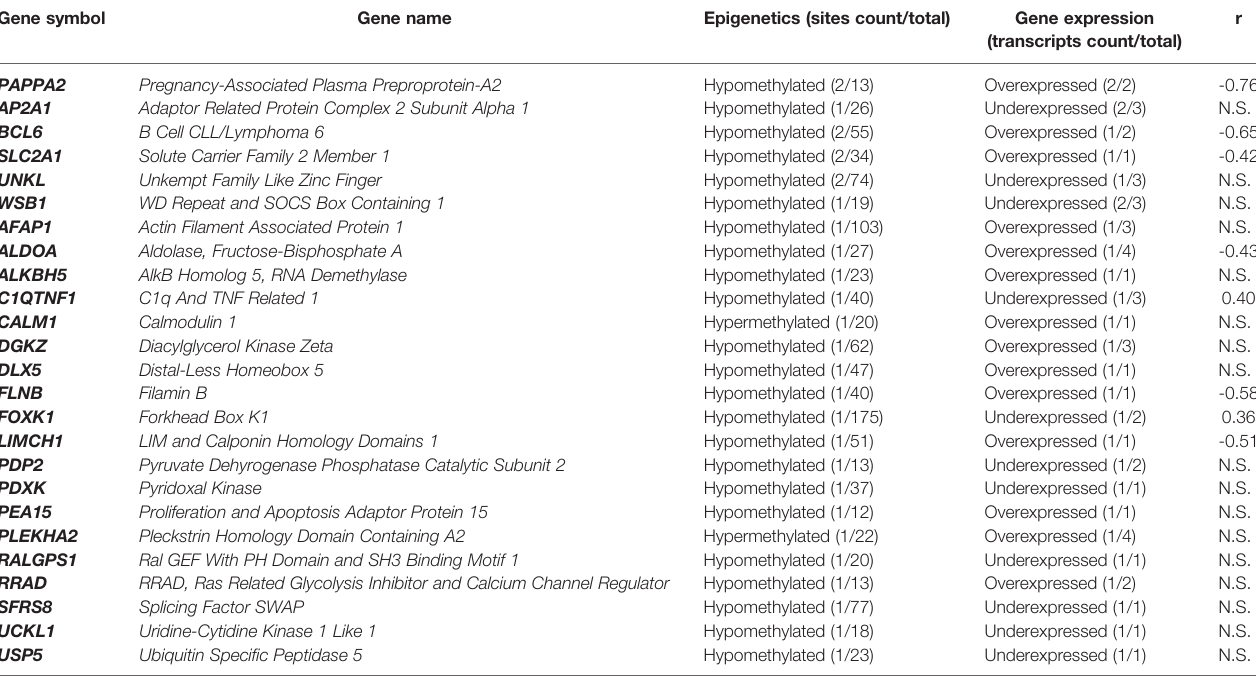
TABLE 2 | Genes found altered in both methylome and transcriptome. Numbers in brackets refer to the number of methylation sites (methylome) and transcripts (transcriptome) found signi fi cantly altered. Gene symbol Gene name